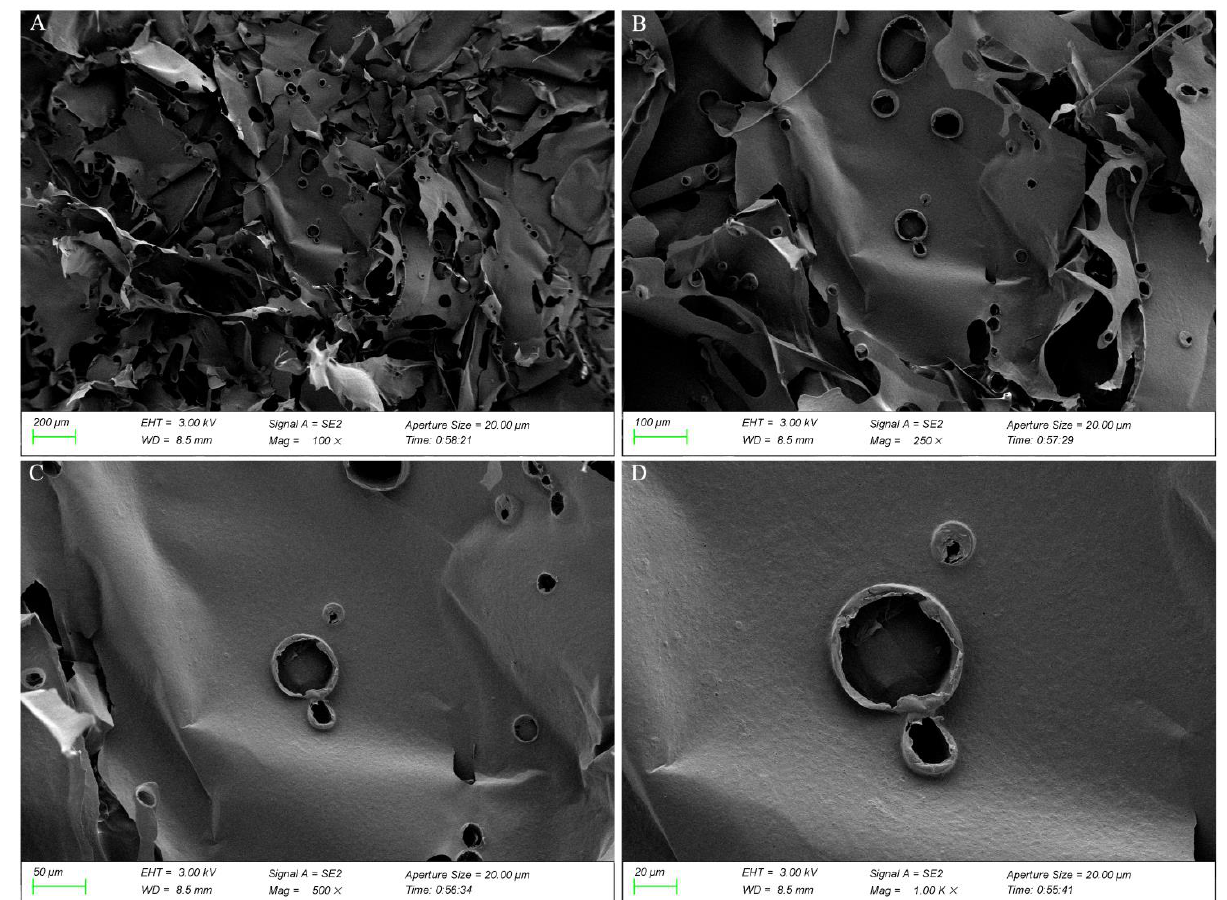
Figure 6. Scanning electron microscopy (SEM) images of GP2a at ( A ) 100×; ( B ) 250×; ( C ) 500×; ( D )